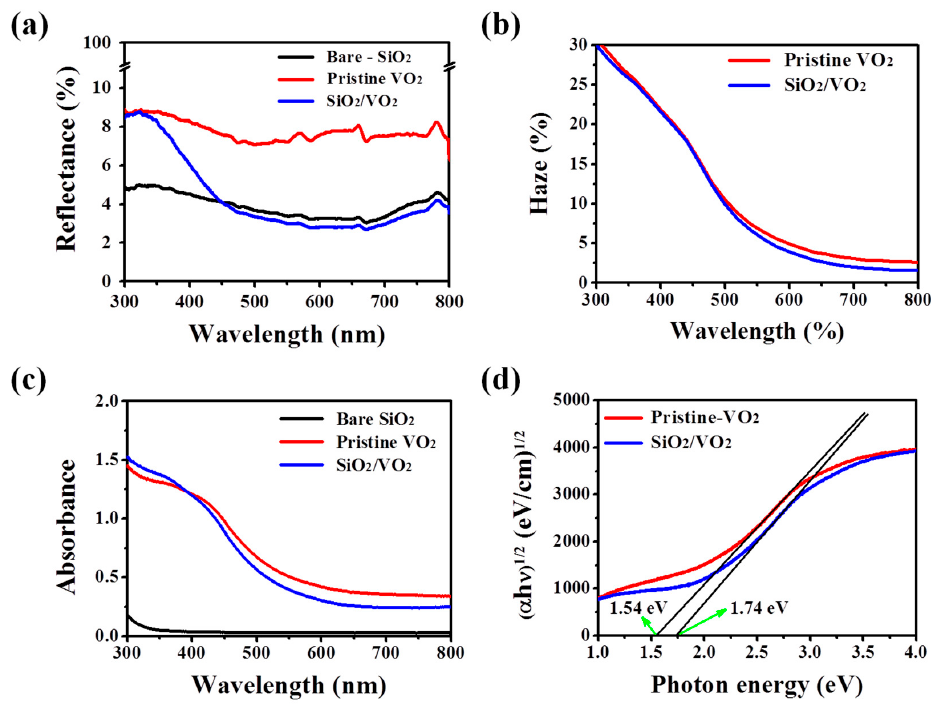
Figure 4. Optical analysis data for each film based on the reflectance ( a ); haze ( b ); absorbance ( c ) and optical band gap graph ( d ).